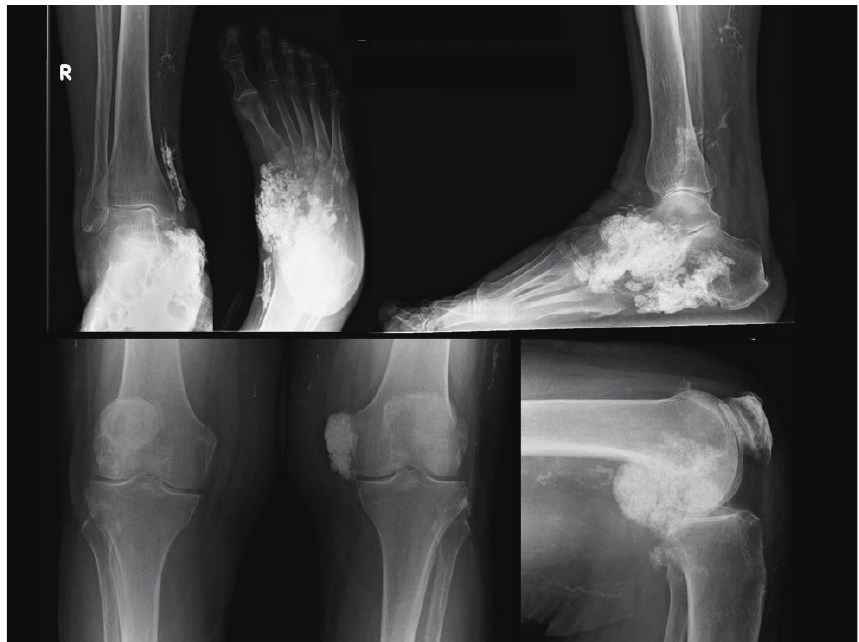
Figure 3: AP and lateral views of her right ankle and left knee show multiple manifestations and joint involvement of her calcinosis.